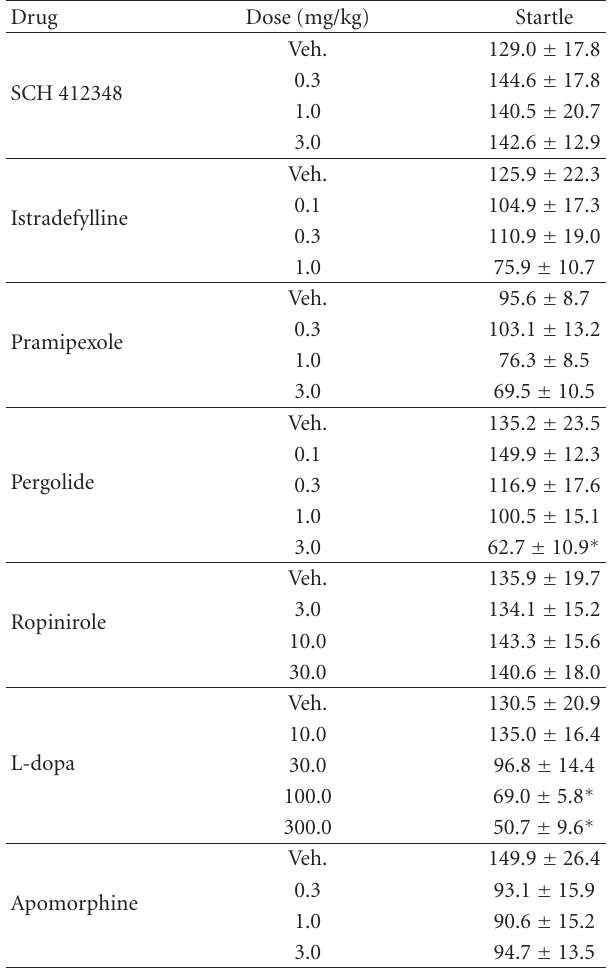
Table 2: Mean startle magnitude ± SEM in mouse prepulse inhi- bition ( ∗ P < 0 . 05 versus